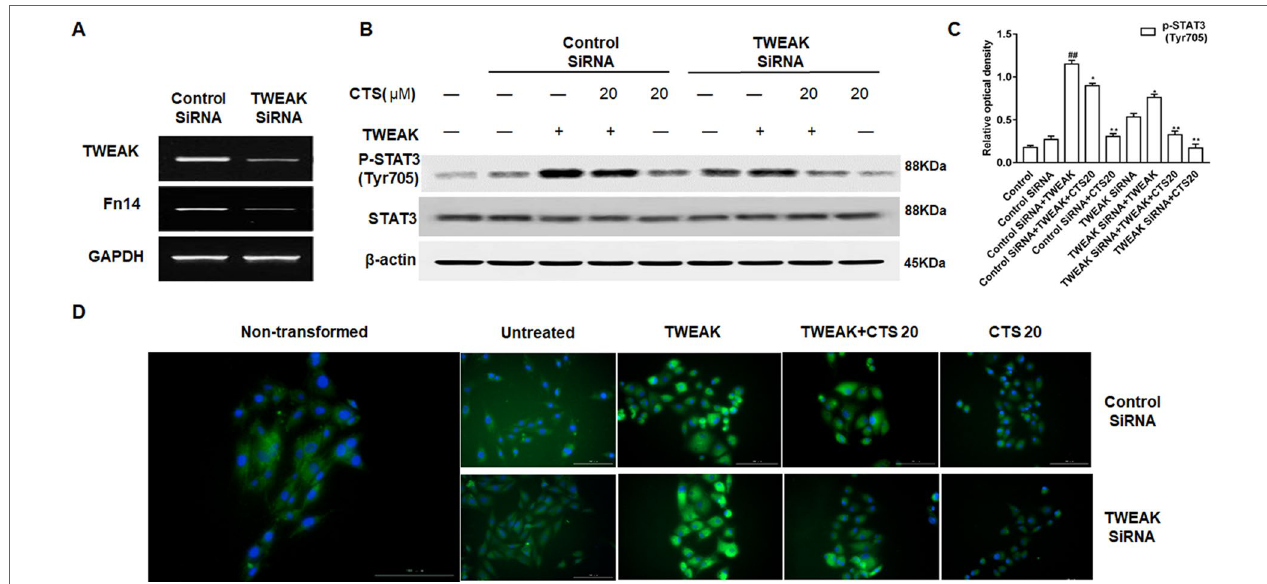
FIGURe 8 | The effect of tumor necrosis factor-like weak inducer of apoptosis (TWEAK) low expression on the phosphorylation of STAT3 in the TWEAK- induced airway smooth muscle cells (ASMCs). (A) The expressions of TWEAK and Fn14 in the TWEAK-silenced ASMCs were verified by reverse transcription polymerase chain reaction. (B) The protein levels of p-STAT3 (Tyr705) and STAT3 in ASMCs were detected by Western blot after knockdown with TWEAK small interfering RNA. (C) Densitometric analysis was presented as the relative ratio of each molecule to Smad2/3, β-actin, and STAT3. Data were presented as mean ± SEM (n = 3). ##P < 0.01 vs. untreated group; *P < 0.05, **P < 0.01 vs. TWEAK-induced group. (D) The immunofluorescence analysis of p-STAT3 (Tyr705) in ASMCs showed that this protein was mainly expressed in the cytoplasm of ASMCs. Magnification: 200×. As shown in the pictures, p-STAT3 (Tyr705) was stained green and nuclei was stained with 4′,6-diamidino-2-phenylindole showing a blue color.